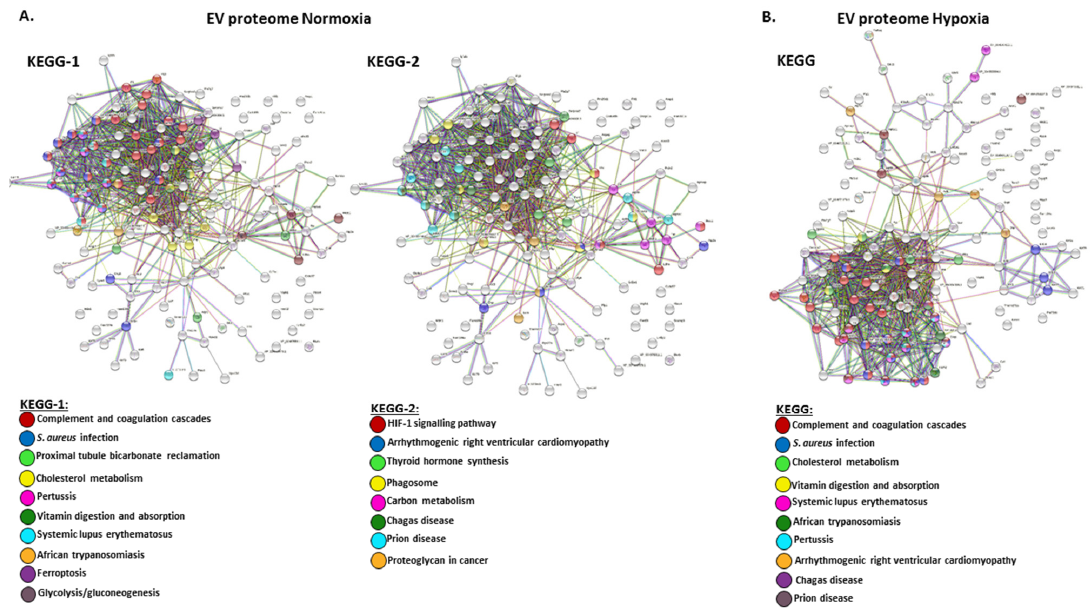
Figure 3. KEGG pathway analysis for protein network analysis for EV total protein cargo, showing predicted protein networks annotating associated KEGG pathways for total protein of plasma EVs from ( A ) normoxia-treated mole-rats and ( B ) hypoxia-treated mole-rats. The protein cargo of circulating plasma EVs from naked mole-rats from normoxia and hypoxia treatment was then compared for predictive protein networks. Overlapping KEGG pathways for normoxia and hypoxia EV cargo proteomes were complement and coagulation cascades, Staphylococcus aureus infection, cholesterol metabolism, pertussis, vitamin digestion and absorption, systemic lupus erythematosus, African trypanosomiasis, arrhythmogenic right ventricular cardiomyopathy, Chagas disease, and prion disease. KEGG pathways specific to the normoxia EV proteome were proteoglycan in cancer, proximal tubule bicarbonate reclamation, ferroptosis, glycolysis/gluconeogenesis, HIF-1 signalling pathway, thyroid hormone synthesis, phagosome, and carbon metabolism (Figure 3 and Table 2A). No KEGG pathways were specific to the hypoxia EV proteome only. Table 2. ( A.) KEGG pathways and (B.) STRING pathways for total proteomic content of plasma EVs from naked mole-rats treated in normoxic and hypoxic conditions, respectively, as assessed by LC- MS/MS analysis. A tick (V) indicates whether the pathway was identified for the EV protein cargo in the respective experimental group; the observed gene count for the pathway is indicated in brackets; blue highlighted rows indicate pathways identified in the normoxia group only, and pink highlighted pathways indicate pathways identified in the hypoxia group only.